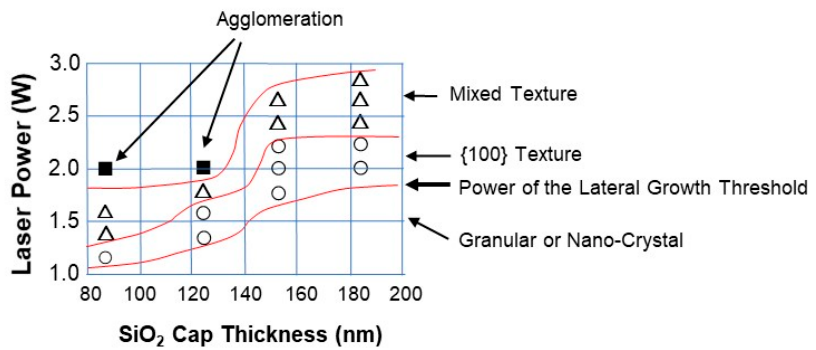
Figure 8. Phase diagram of the {100} texture and mixed texture. The scan velocity was 15 mm/s. After After Sasaki et al. Sasaki et al. [44].